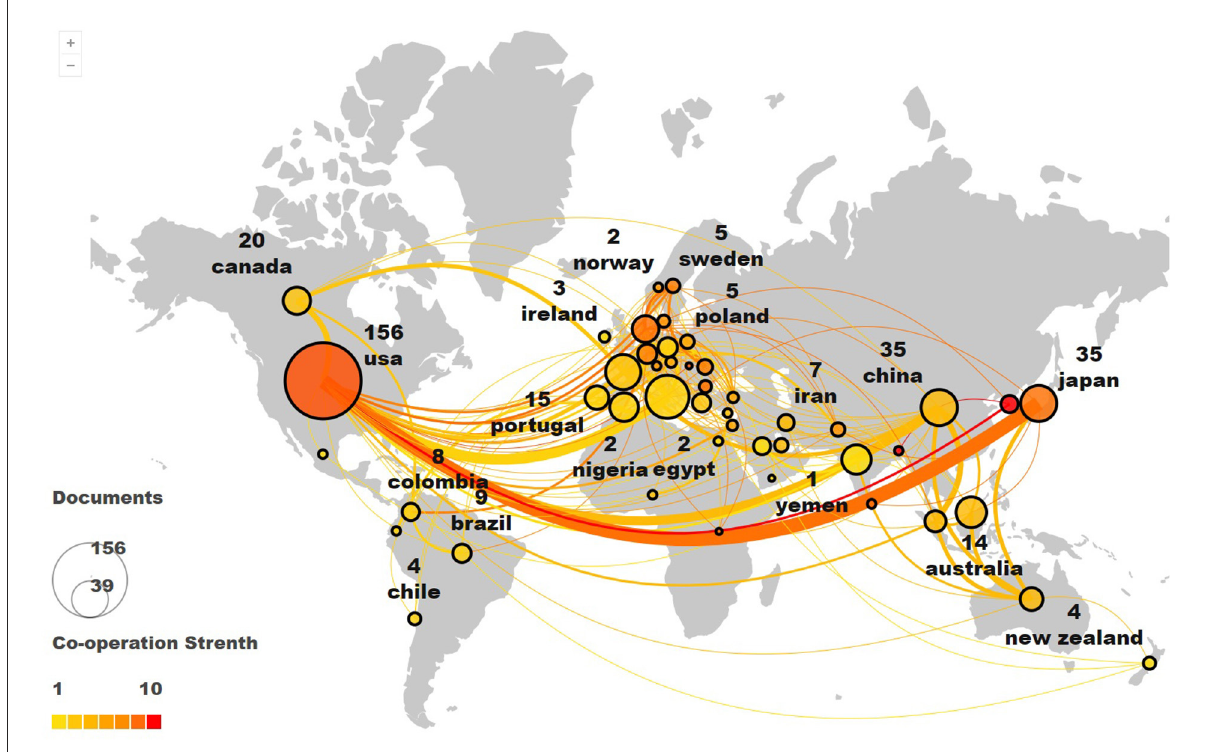
FIGURE2 The collaboration network of countries researching Al on ASD.